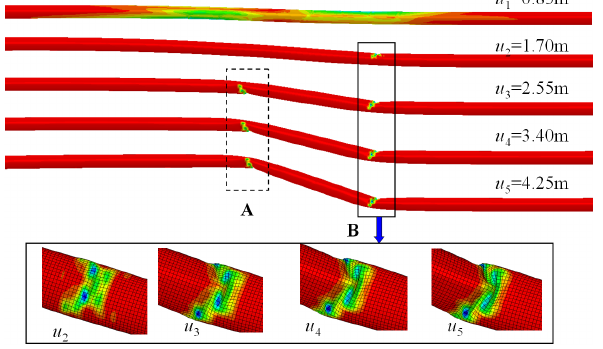
Figure 3. Buckling behaviors of the non-pressure pipeline under different reverse fault displacements.